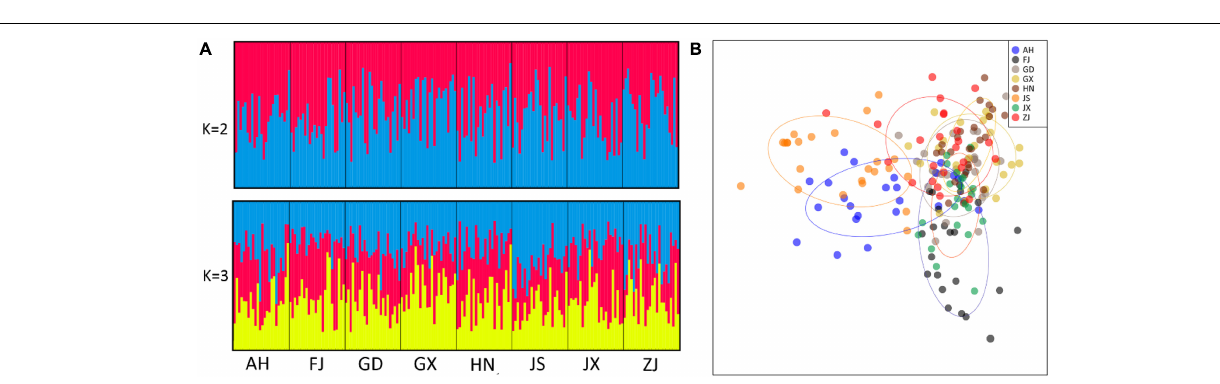
FIGURE 5 | Genetic structure of Phyllotreta striolata populations from southern China inferred from STRUCTURE (A) and DAPC (B) analyses based on 12 microsatellite loci. The optimal number of clusters for the STRUCTURE analysis was three; K = 2 and 3 are presented (A) arranged by population. DAPC analysis shows all populations are clumping together (B)